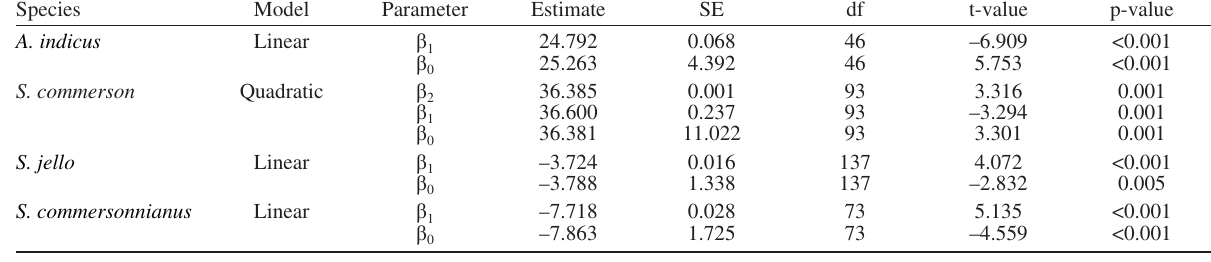
Table 1. – Generalized linear mixed model parameters for Indian threadfish, narrow-barred Spanish mackerel, pickhandle barracuda and talang queenfish in which model and parameter refers to the chosen model [constant ( β the value of the slope or intercept; SE, standard error of the estimate; and df, degrees of freedom.